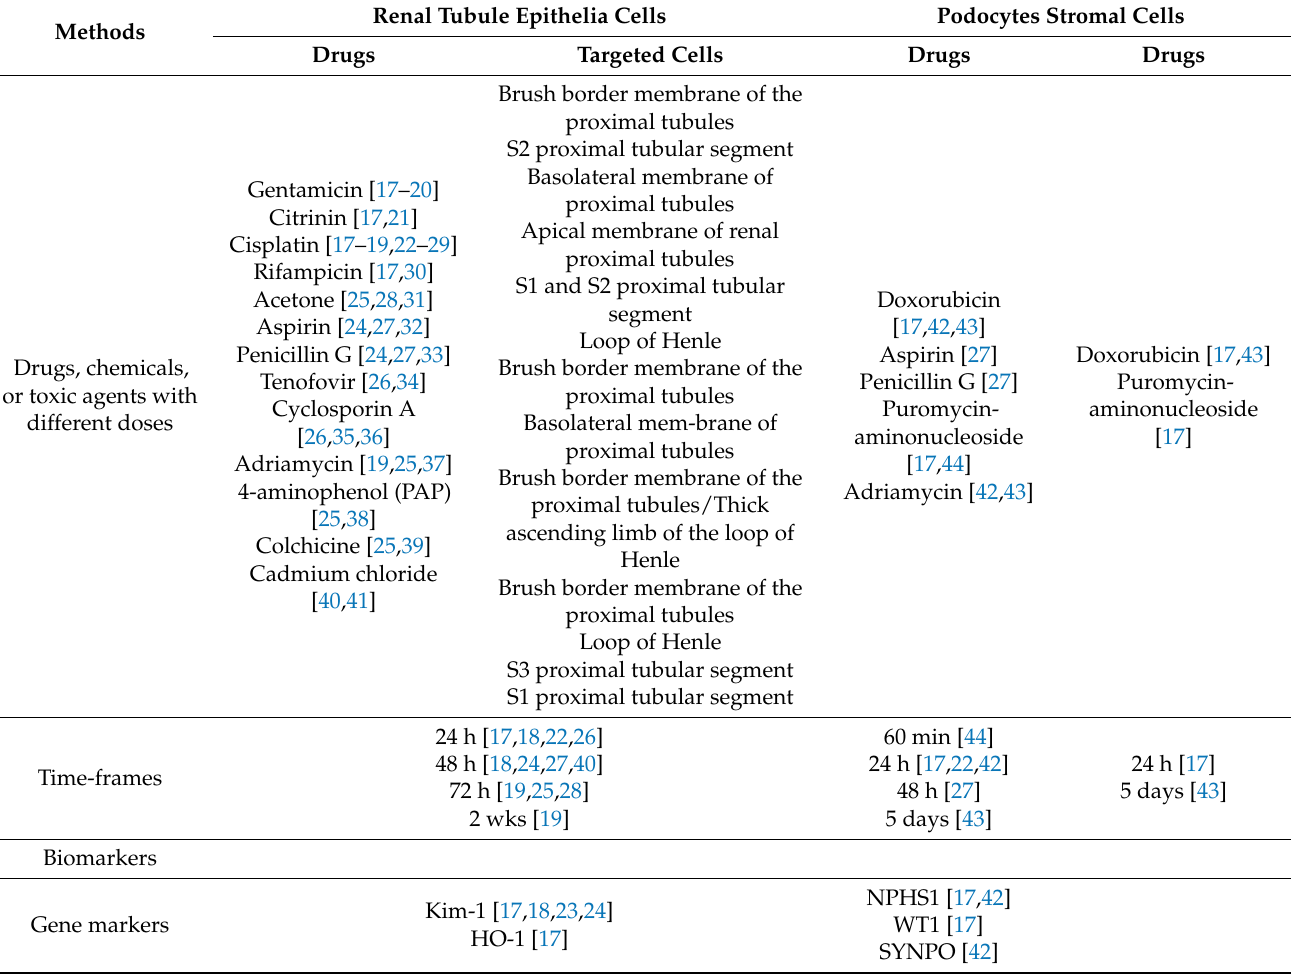
Table 1. Methods used for in vitro nephrotoxicity assessment in 3D models and in vivo renal tissues.